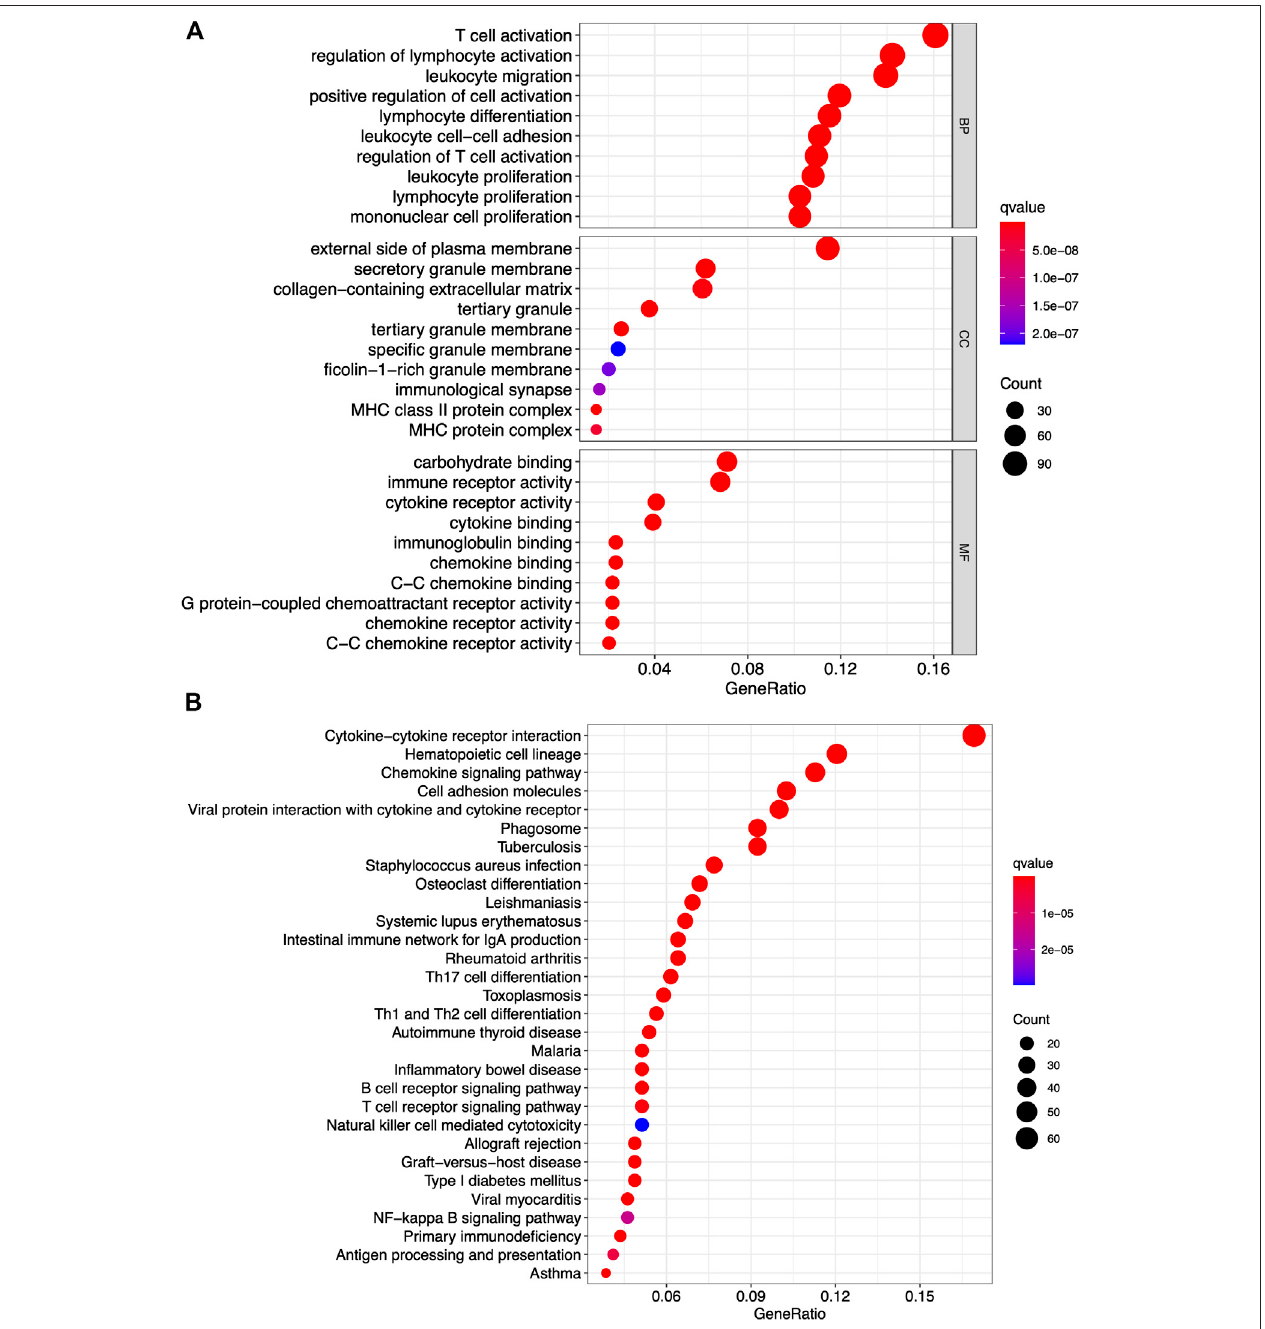
FIGURE 4 | GO and KEGG pathway analyses of differentially expressed gene. (A) Top 10 GO terms in cellular component, molecular function, and biological processes. (B) KEGG pathway enrichment analysis of indicated biological processes. Only both p value and q value less than 0.05 were considered signi fi cant.